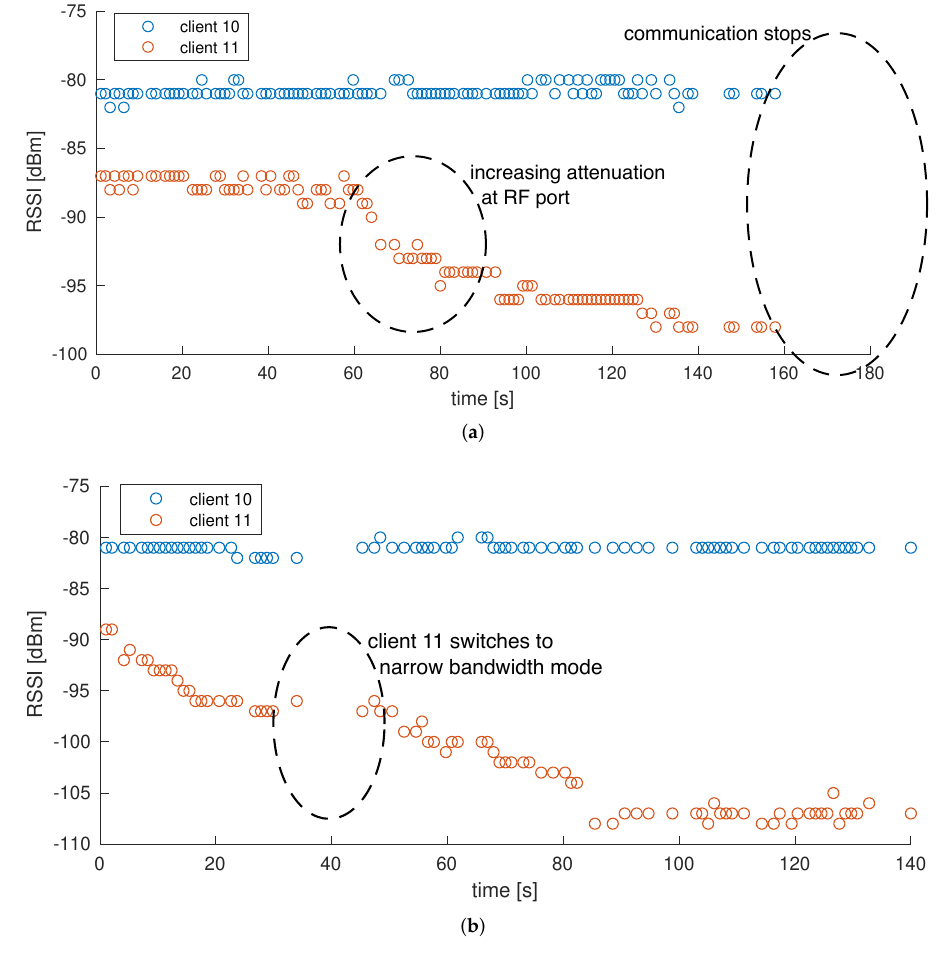
Figure 12. Measured received signal strength information (RSSI) from clients 10 and 11, both connected to AP4, after a data stream is set up between the two clients. The attenuation at the RF port of client 11 is gradually increased to test the reconfiguration algorithm. ( a ) monitoring loop disabled. ( b ) monitoring loop active, a reconfiguration is